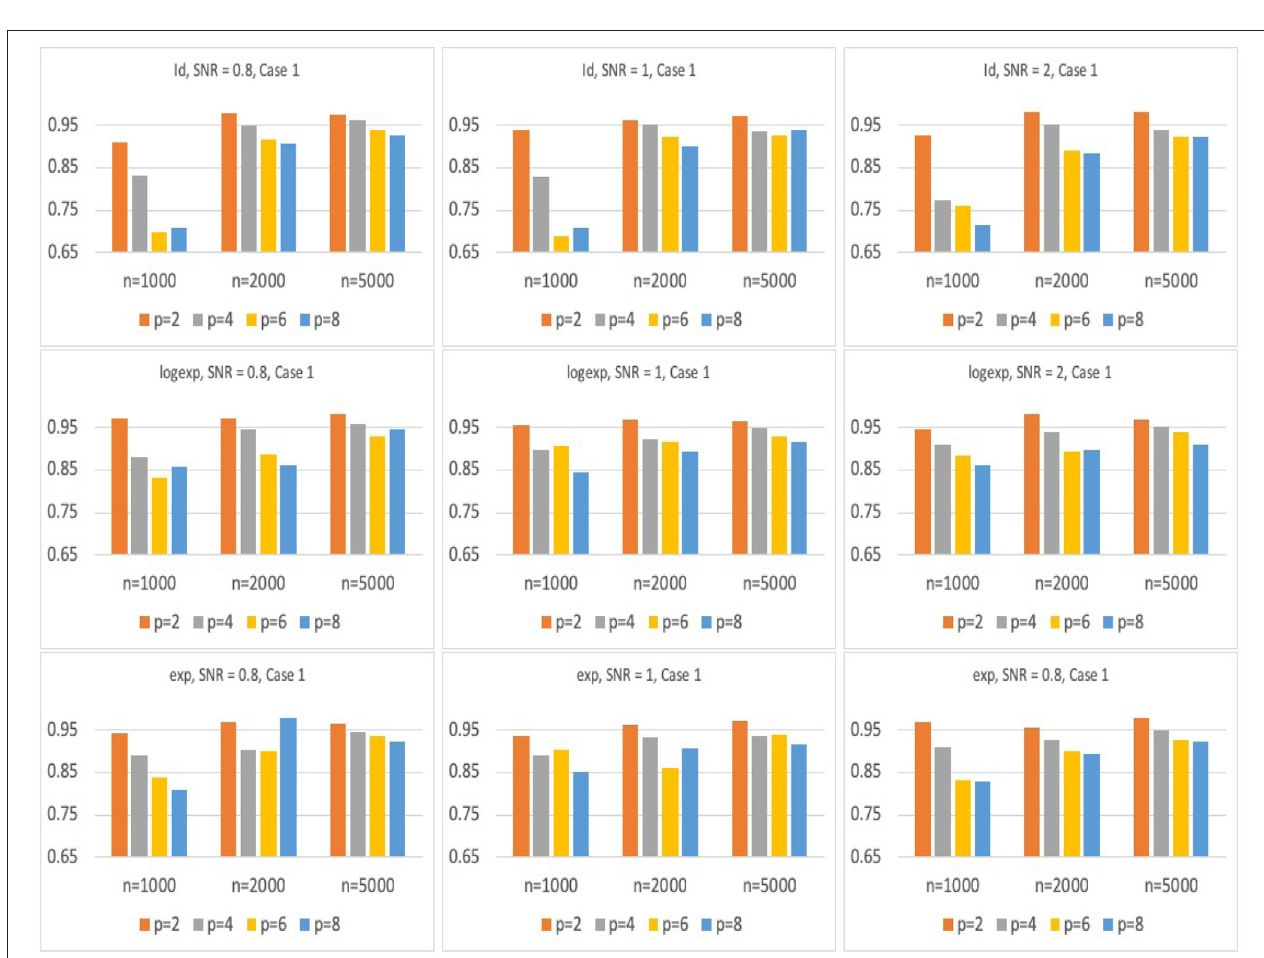
FIGURE 2 | Simulation results of the coverage probability for Model 1 with three different link functions, sample size of n = 1,000,2,000,5,000, and p = 2,4,6,8. For each case, prediction coverage probability is calculated over the samples in the testing data set.